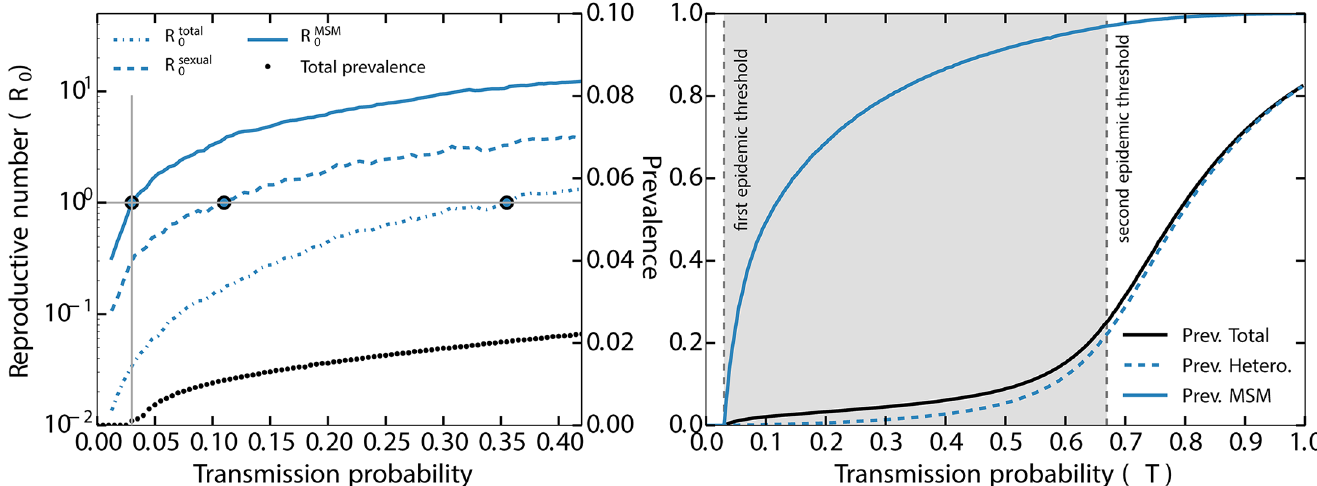
Fig 2. left panel: Considering a scenario in which women are 10 times less likely to transmit ZIKV than men ( ε = 10), the dotted, dashed and solid lines show three estimates of the basic reproductive number R 0 associatedwith sexual transmissions: (i) R total is the averagenumber of secondary infections 0 due to all infected individuals, includingby the vector, (ii) R sexual is the averagenumber of secondaryinfectionsresultingfrom individuals infected sexually, 0 and (iii) R MSM 0